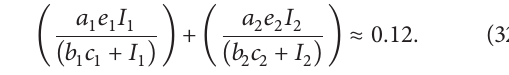
Figure 1: The illustration on the existence of the coexistence equilibrium. The gray closed area denotes the region Ω = [0,𝐼 1 /𝑏 1 ]× /𝑏 ] , the blue curve denotes the curve 𝑦 = 𝜑 [0, 𝐼 2 2 curves represent the curves 𝑦 = 𝜑 2 (𝑥) with the change of 𝑚 , 𝑚 = 0.05 , 𝑚 = 0.1 , 𝑚 = 0.15 , and 𝑚 = 0.2 , and the red diamond implies the crossover point of 𝑦 = 𝜑 2 (𝑥) and 𝑦 = 𝜑 1 (𝑥) , where 𝐼 1 = 0.4 and the other parameters are the same as in Table